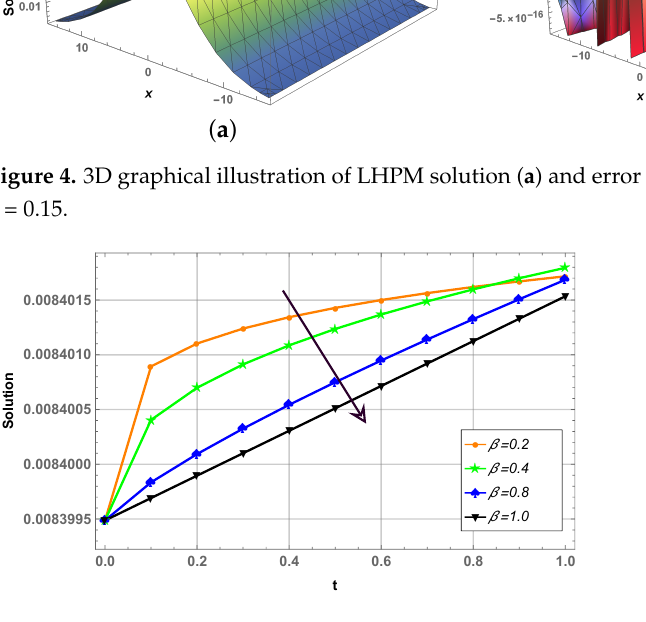
Figure 5. Effect of fractional parameter β on time-fractional Sawada–Kotera equation (Example 1) when k = 0.1 and x = 10.